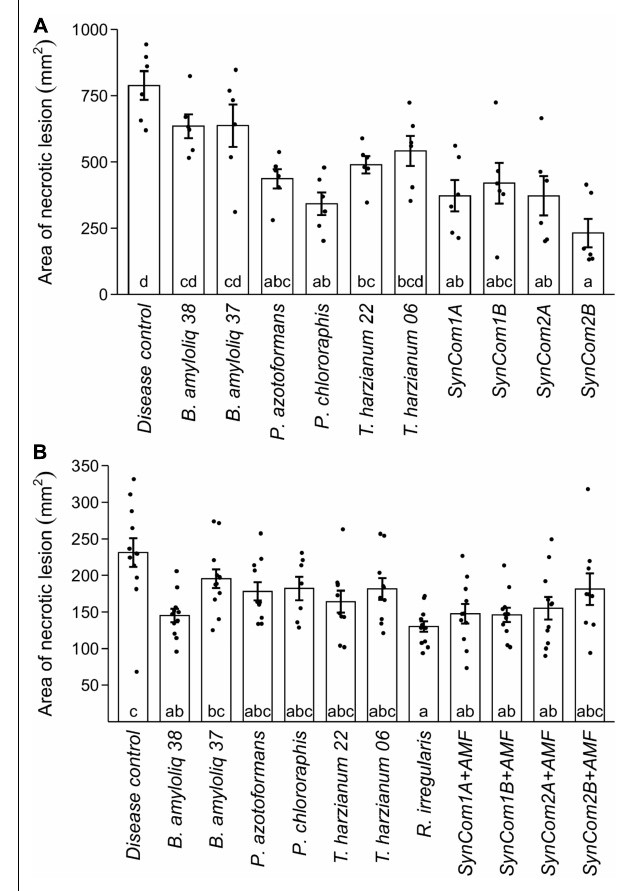
FIGURE 2 | Effect of microbial inoculation on disease caused by the foliar pathogen Botrytis cinerea. (A) Area of necrotic lesions in plants pre-treated by foliar spray with the different treatments (see Supplementary Table 2 ). Water-treated plants (no BCA treatment) were included as disease control. (B) Area of necrotic lesions in plants inoculated at sowing either with water (disease control) or with the different microbial treatments (see Supplementary Table 2 ) to determine ISR. Single strains were inoculated at 1 × 10 7 cfu/ml in (A) and cfu/plant in (B) , and the consortia were inoculated at the same concentration for each microorganism (SynCom1A, SynCom2A) or at 1 × 10 7 cfu/ml in (A) and cfu/plant in (B) as total microbial concentration (SynCom1B, SynCom2B). +AMF indicates consortia co-inoculated with 1,000 spores/plant of Rhizophagus irregularis. Bars represent means ± SE and black dots represent raw data. Treatments not sharing a letter in common are significantly different based on the general linear model and Tukey honestly significant difference (HSD) test [ p < 0.05, n = 6 in (A) , n = 12 in (B)